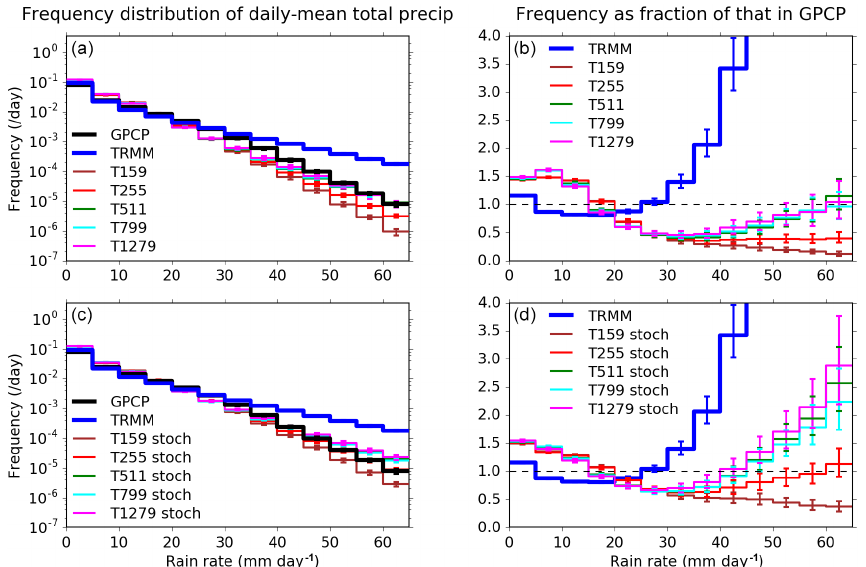
Figure 7. Panels (a) and (c) show the frequency of occurrence of daily-mean rain rates averaged over 2 . 5 ◦ × 2 . 5 ◦ grid boxes between 10 ◦ S and 10 ◦ N in different datasets in 5mmday − 1 intervals, with rates below 0.1mmday − 1 omitted. Panel (a) shows data for GPCP, TRMM and the deterministic Climate SPHINX PDA simulations and (c) shows the same for the PDA simulations with stochastic physics. Note that the vertical axis is logarithmic. Panels (b) and (d) show the rain rates in each simulation and TRMM as a fraction of that in GPCP for the deterministic and stochastic runs respectively. Horizontal dashed lines indicate a fraction of 1, which would correspond to perfect agreement with GPCP. Vertical bars indicate the 95% confidence intervals. The frequency in (a) and (c) corresponds to that for an individual grid box, if all grid boxes were statistically equivalent. Data are shown for 1998–2008, the time period common to all datasets, for all ensemble